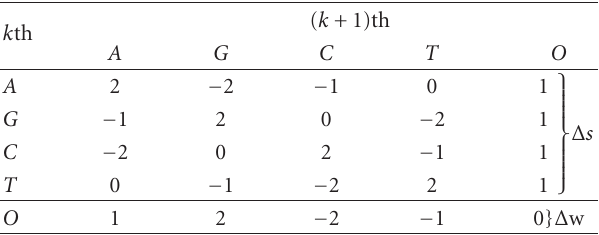
Table 3: Possible values of Δ s and Δ w . The corresponding values of Δ s and Δ w are obtained by substituting the value of x (4), with Δ w / = 0 only if x k =